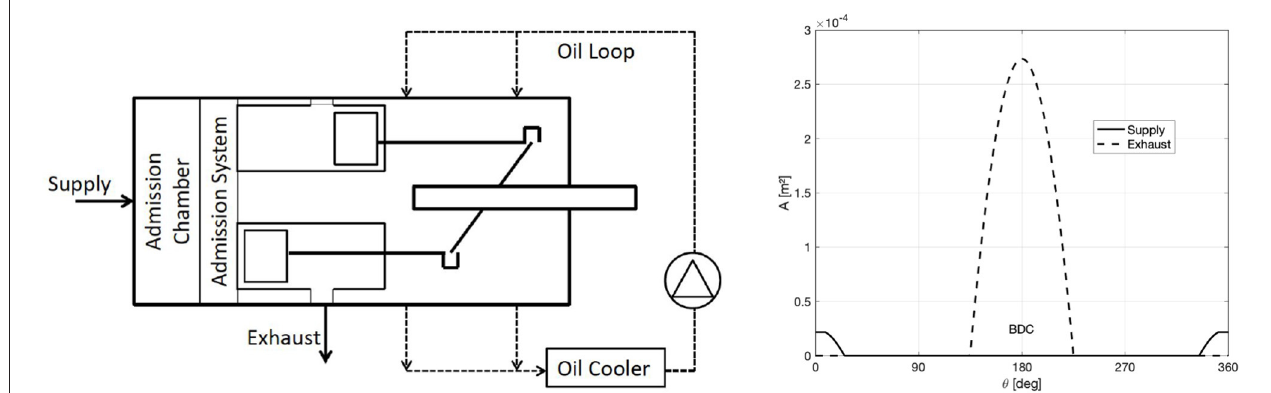
FIGURE 2 | Schematic representation of the swash-plate piston expander (left) and Shaft angle evolutions of cross-sectional areas of supply and exhaust ports (right) .